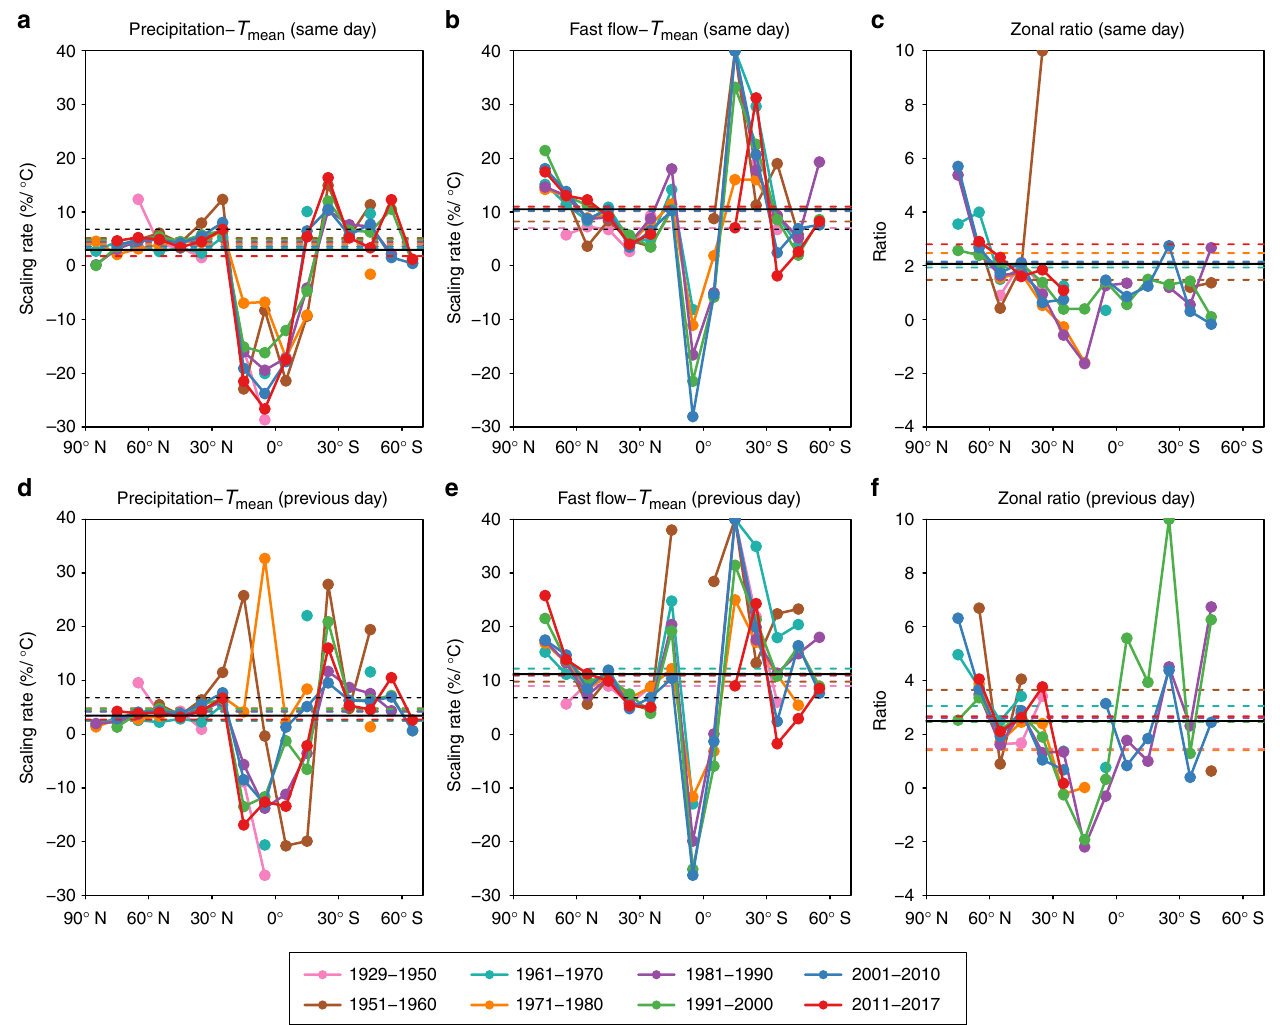
Fig. 4 Zonal scaling rates of 99th percentile precipitation and fast fl ow extremes with local temperature during different periods. a , b Zonal median scaling results with same-day T mean for precipitation extremes ( a ), and fast fl ow extremes ( b ), respectively. d , e Zonal median scaling results with previous-day T fl ow extremes ( e ), respectively. c Zonal median scaling ratio on same-day T mean for precipitation extremes ( d ), and fast mean . f Zonal median scaling ratio on previous-day T mean . Dashed colourful lines indicate the global average scaling or ratio results, solid black lines indicate long-term global average results, and dashed black lines in a , b , d , e indicate C – C